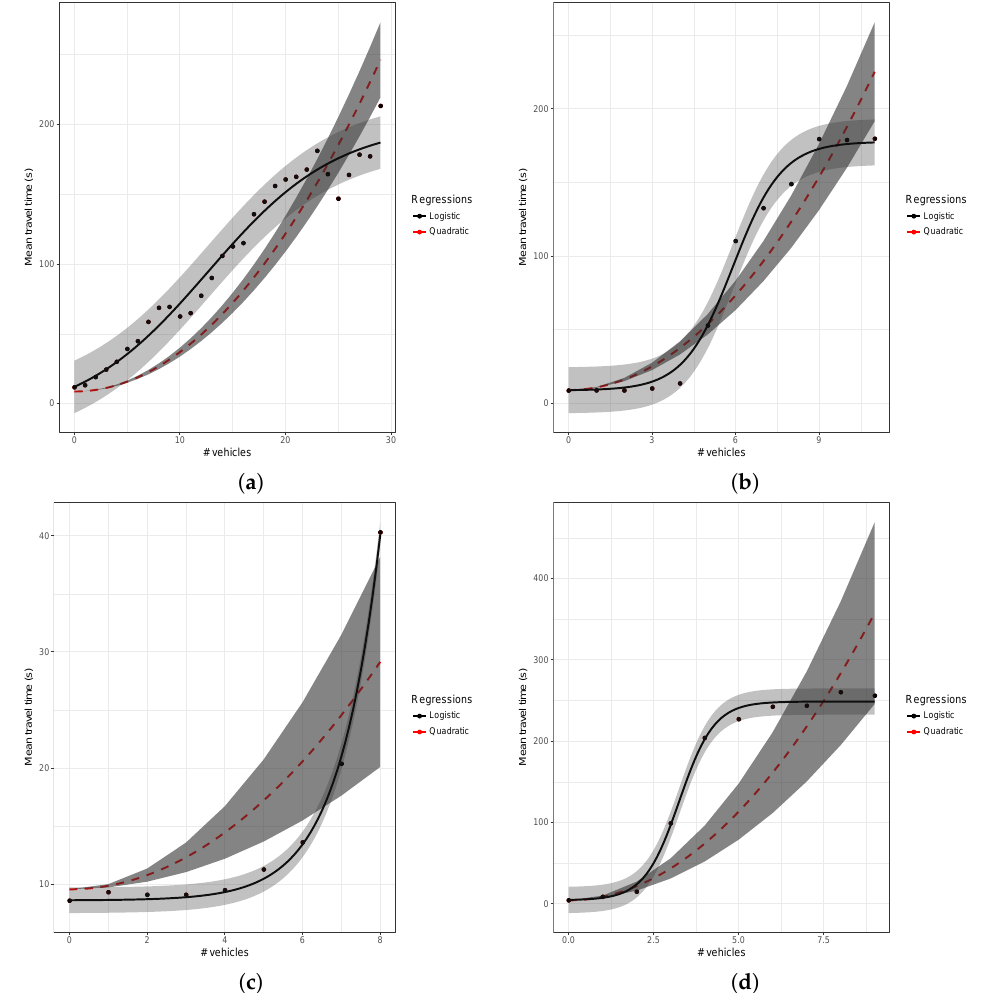
Figure 6. Several examples where the logistic regression outperforms the quadratic